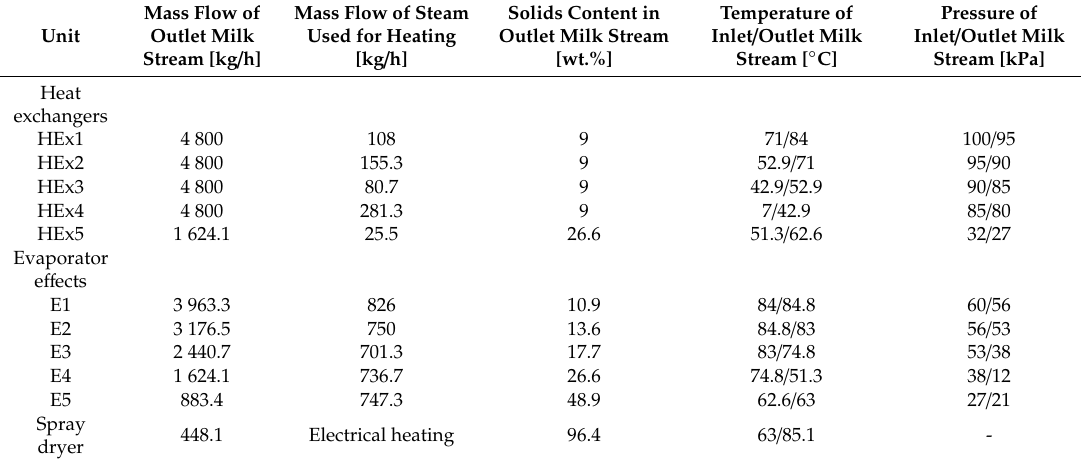
Table 5. Operating values of selected process variables in the new milk drying